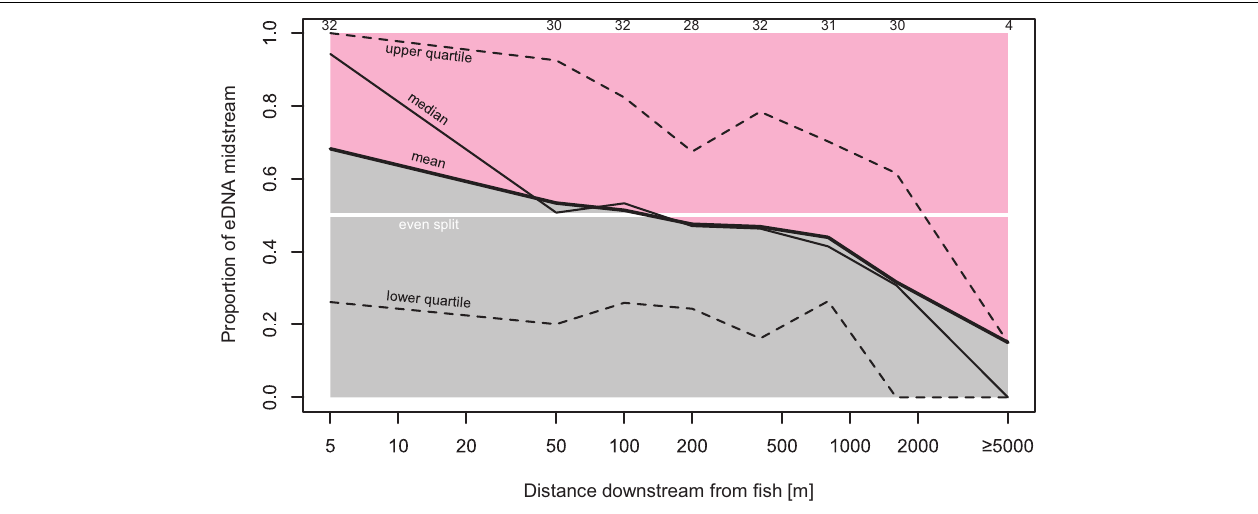
FIGURE 3 | Proportion of bankside versus midstream eDNA. Proportions here are calculated as the midstream eDNA quantity over the midstream eDNA quantity plus the average of both bankside quantities. All sampling transects in which at least one sample had positive detection are included here. Top numbers indicate number of transects included in proportion estimate.